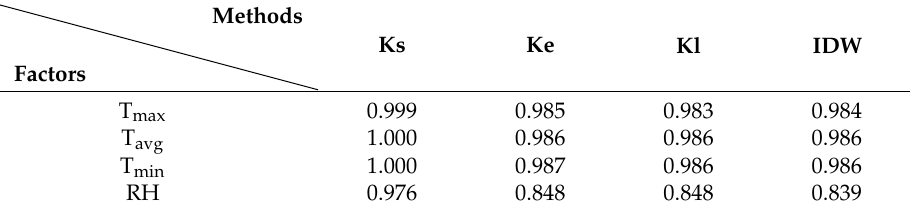
Table 1. Correlation coefficients between the interpolation results and observed